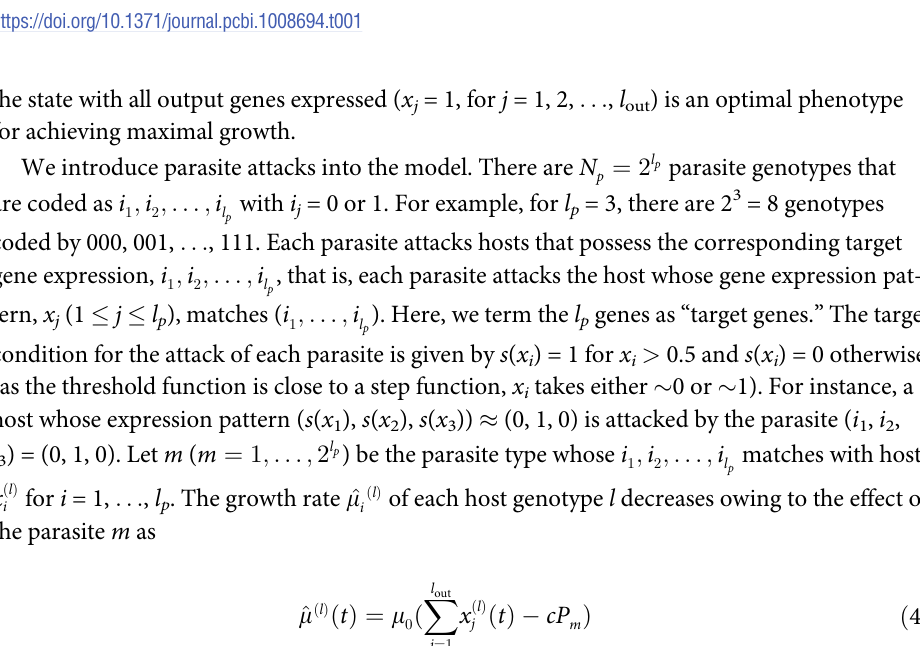
Table 1. Model parameters and variable definitions. Symbol Description